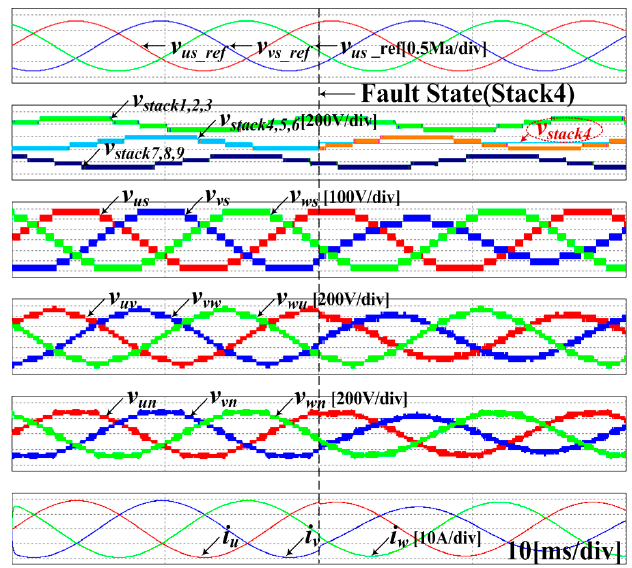
Figure 17. Simulation waveform when V phase 4 th stack fails.